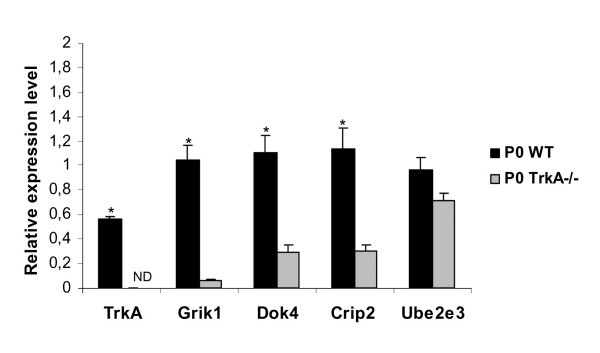
QRT-PCR: Gene expression determined by real-time PCR on P0 and P0 TrkA mutant mouse lumbar DRG. TrkA and Ube2e3 (ubiquitin-conjugating enzyme E2E 3) were used as controls. Data (means ± SEM) were calculated by the delta-CT method [37] on three independent experimental replicates. The arithmetic means of the expression levels of two genes (Polr2j, Ddx48) whose expression do not change in the course of development and in TrkA-/- DRG were used to normalize the expression levels. Data were analyzed using the Mann Whitney U-test (*P < 0.05). ND: Not detected.